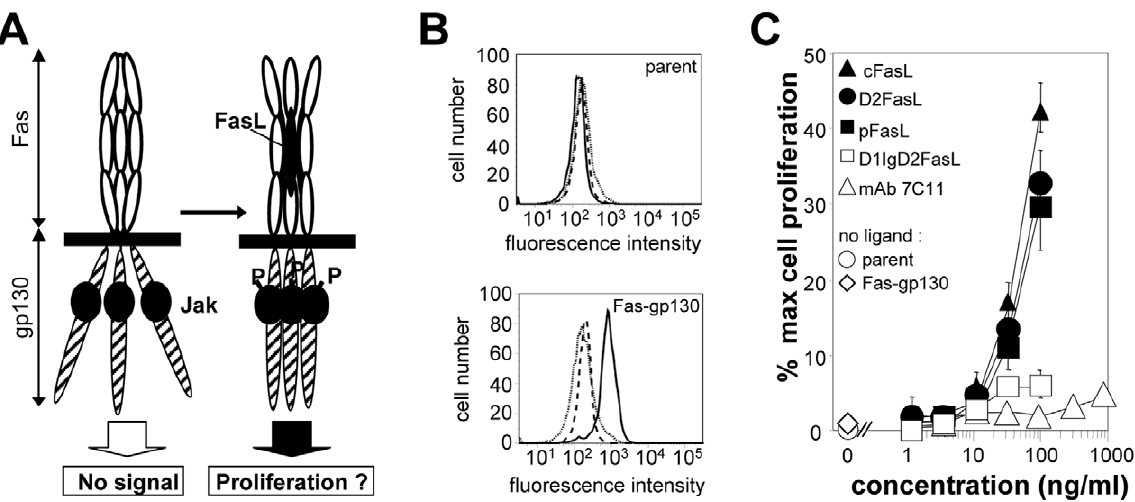
Figure 3. FasL/gp190 chimeras and agonistic antibodies differentially act on Fas conformation. Panel A: Description of the model used to analyze the requirement for a Fas conformational change during its activation. The Fas-gp130 hybrid receptor is stably expressed in the IL-3 dependent BA/F3 cell line. Panel B: Cell surface staining of parent BA/F3 cells (upper panel) and on a representative clone stably expressing the Fas- gp130 chimera (lower panel), with an isotype-matched control (dotted line), anti-murine Fas JO2 (dashed line) and anti-human Fas DX2 (continuous line). Living cells were gated on the basis of the morphological parameters. Panel C: Fas-gp130 BA/F3 cells were incubated with the indicated Fas triggers or controls, and proliferation was measured using a MTT assay. Results are expressed as percentages of the maximum proliferation obtained with a saturating IL-3 concentration. Proliferation of parent and transfected cells was also measured in the absence of any IL-3 or Fas trigger. Values are the mean 6 sd of 3 independent experiments.